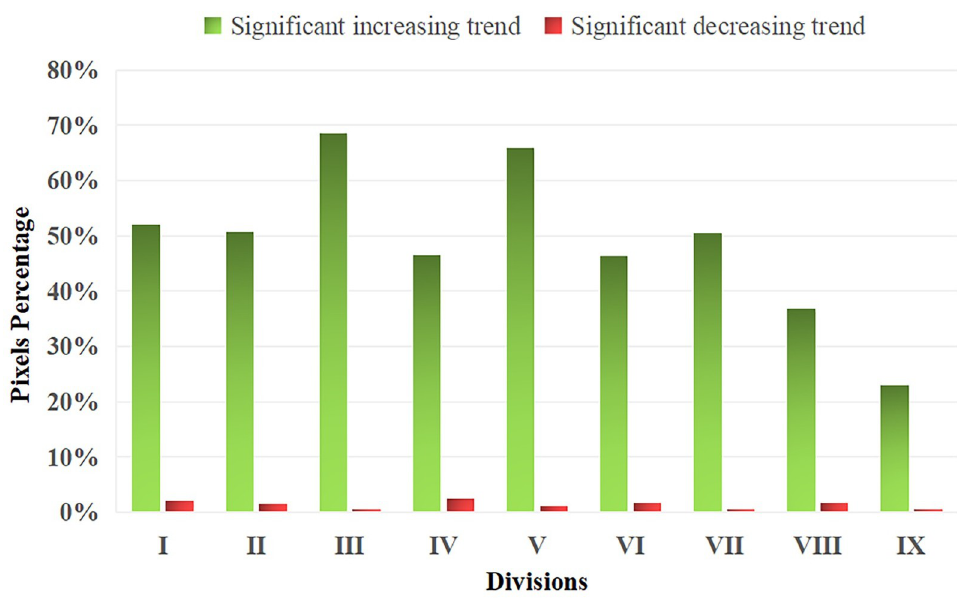
Fig 6. Percentage of significant variation trend of NDVI in the nine divisions in Northeast